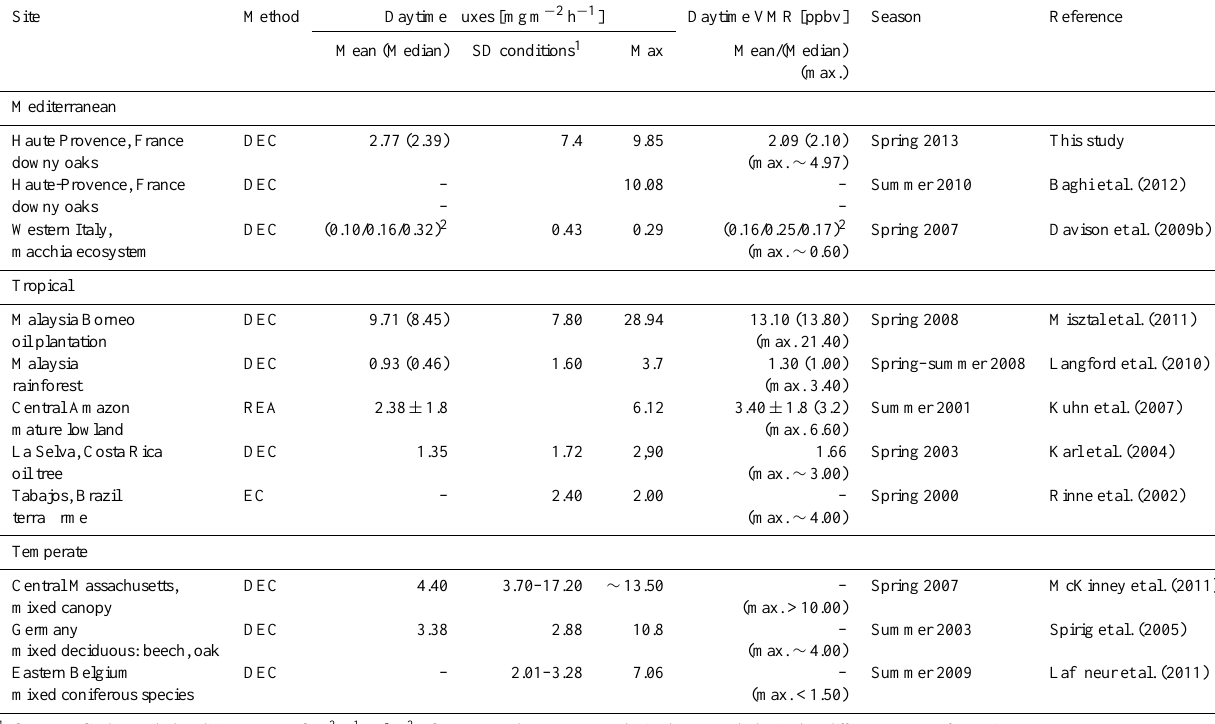
Table 4. Non-exhaustive overview of above-canopy isoprene fluxes and